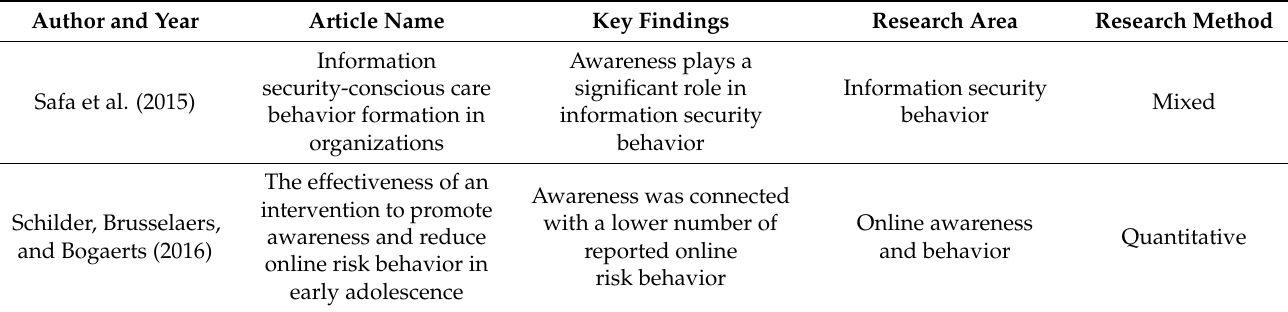
Table A5. User behavior when using the